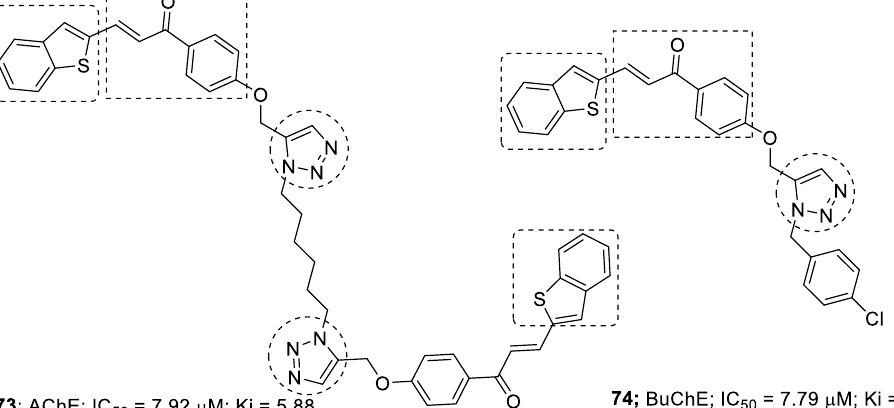
Figure 25. Chemical structures of chalcone – 1,2,3-triazole hybrids.